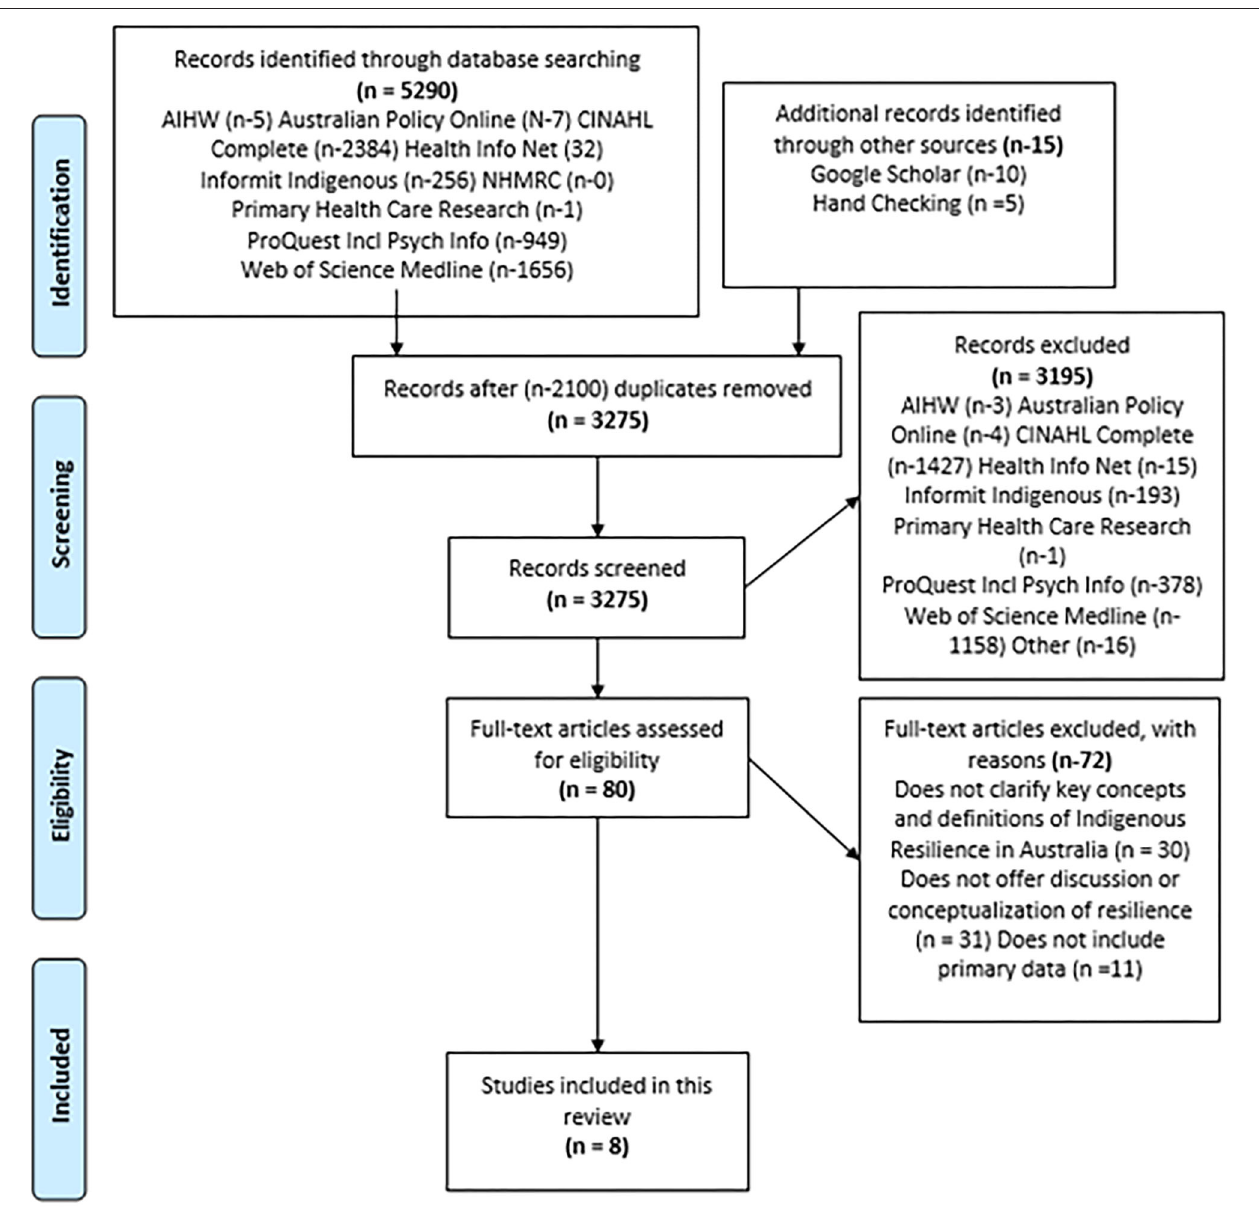
FIGURE 1 | Prisma flow